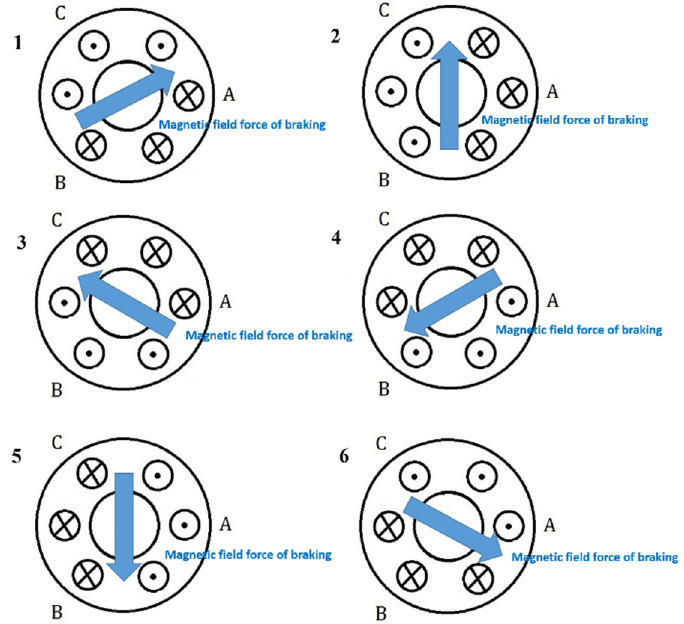
Figure 7. Direction of the combined magnetic field forces of the PMSM stator coils constructed by six basic voltage vectors when braking.